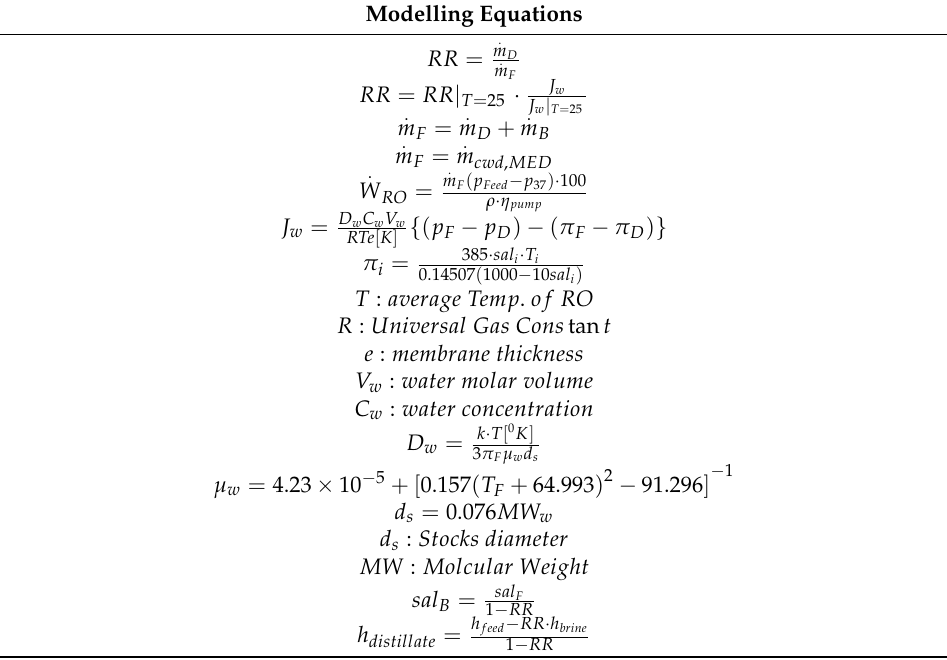
Table A2. Modelling equations for the RO desalination unit [3].